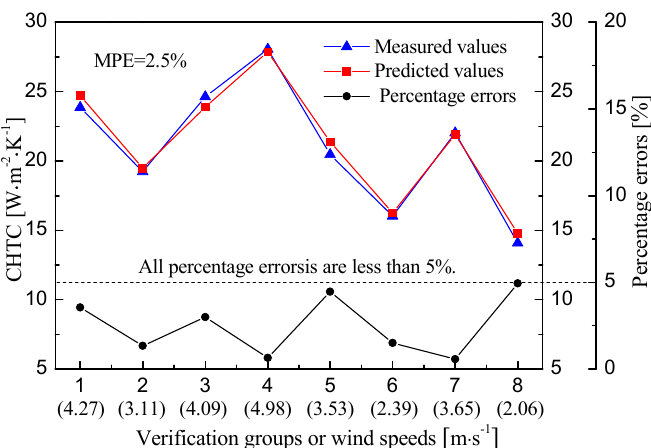
Figure 7. Comparative results between predicted and measured CHTCs.